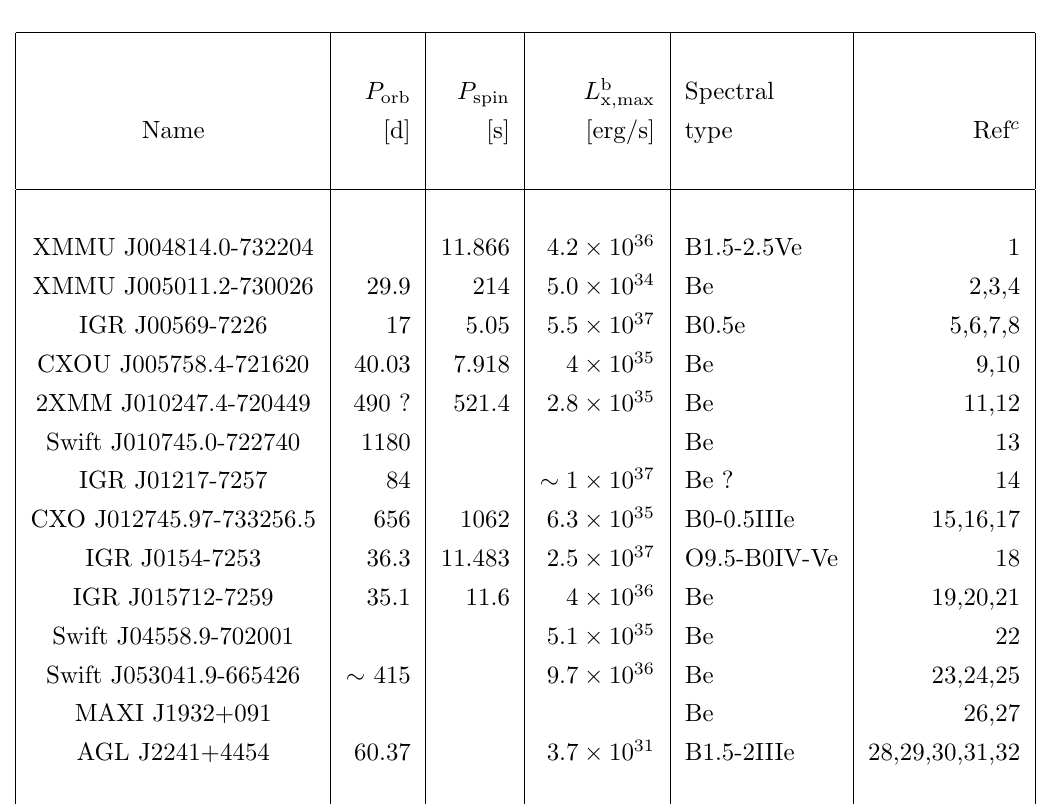
Table 1: New Be X-ray Binaries